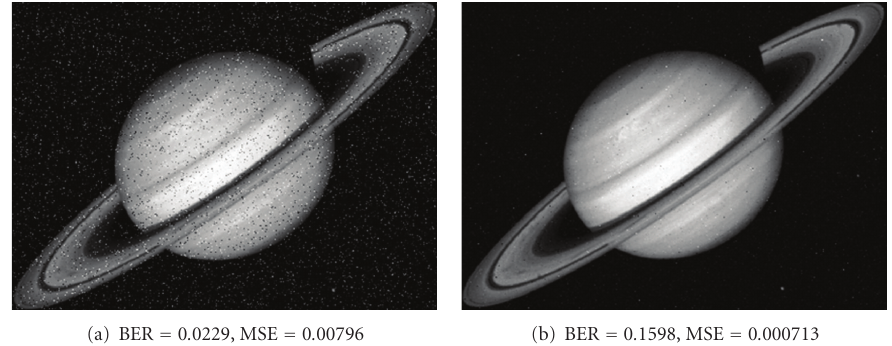
Figure 2: Impact of MSE and BER on the perceptual quality of reconstructed images